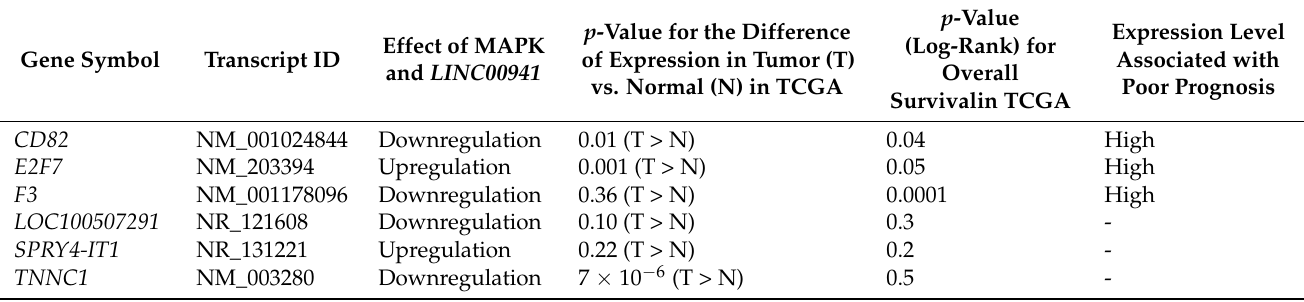
Table 2. Concordantly altered genes between MAPK attenuation and knockdown of LINC00941 .